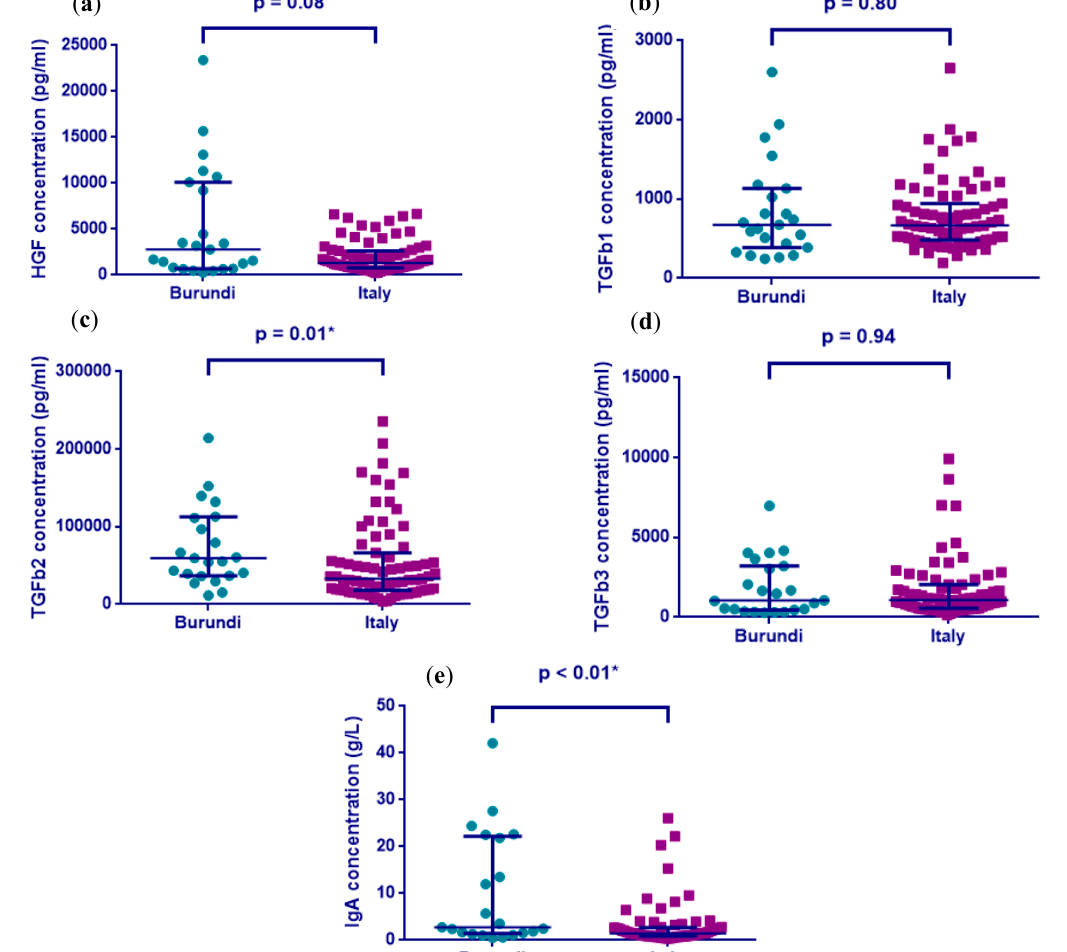
Figure 1. Comparison of growth factors: ( a ) hepatocyte growth factor (HGF), ( b ) transforming growth factor- β 1 (TGF- β 1), ( c ) TGF- β 2, ( d ) TGF- β 3, and ( e ) immunoglobulin A (IgA) raw concentrations in